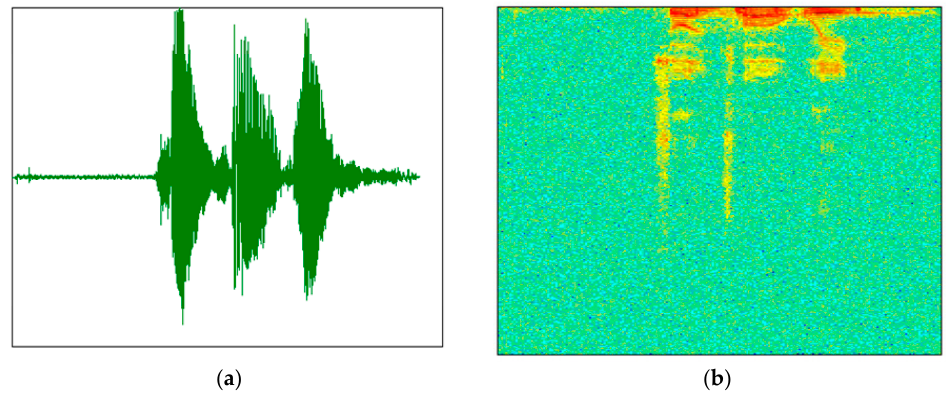
Figure 2. Speech signal—speech spectrogram conversion diagram. ( a ) Original speech signal and ( b ) speech spectrogram.